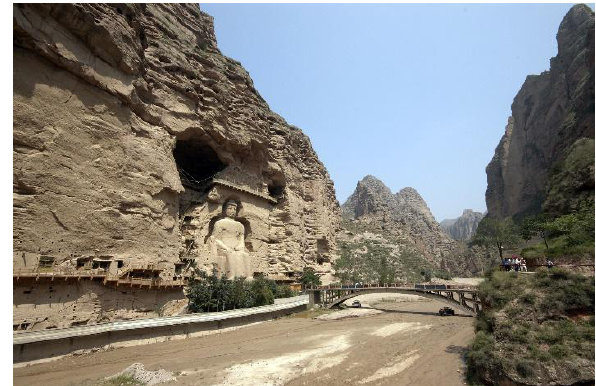
Figure 3. The Bingling